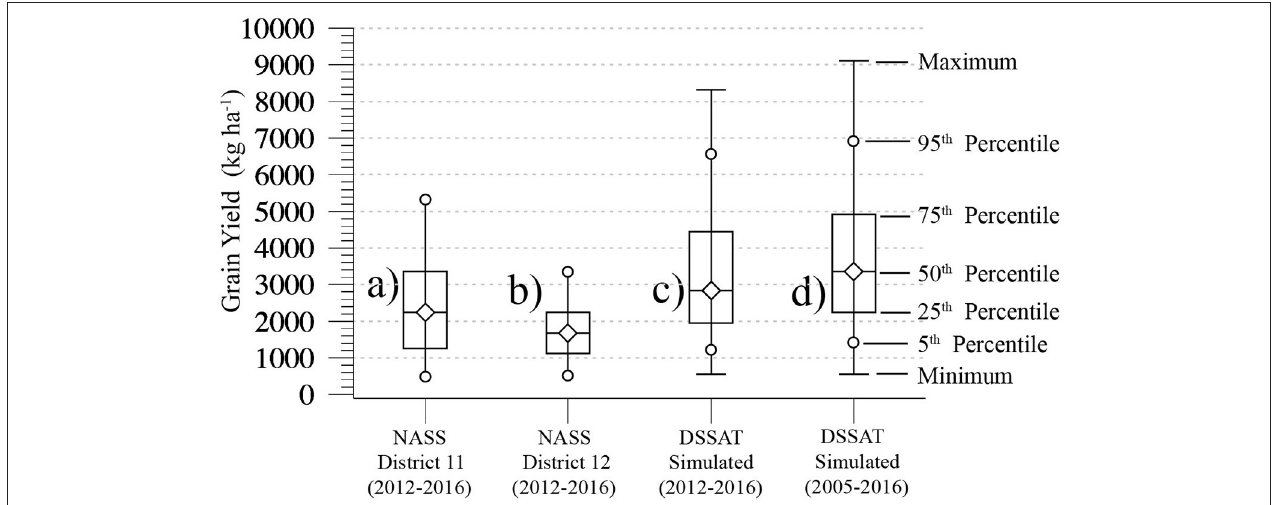
FIGURE 2 | (a) Sorghum grain yield percentiles of aggregated NASS District 11 yield reports during the 2012–2016 cropping years. (b) As in (a) for NASS District 12 yield reports. (c) Grain yield percentiles of CERES-Sorghum simulations aggregated over 21 locations and 32 management options during 2012–2016 (3,360